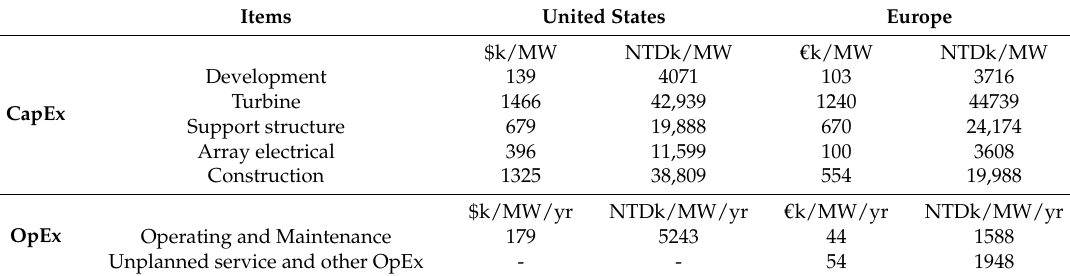
Table 4. Expenditures of offshore wind farms in the United States and Europe.